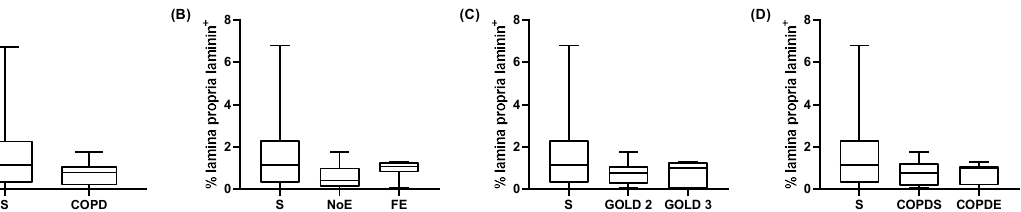
Figure 4. Quantification of laminin expression. Laminin expression was compared between ( A ) COPD patients and smoking controls (S), with further detailed clinical phenotyping in COPD patients based upon ( B ) exacerbations, ( C ) airflow limitation, and ( D ) smoking status. Data presented as median ± range. Comparisons between groups were made by one-way Kruskal–Wallis followed by Dunn’s tests.